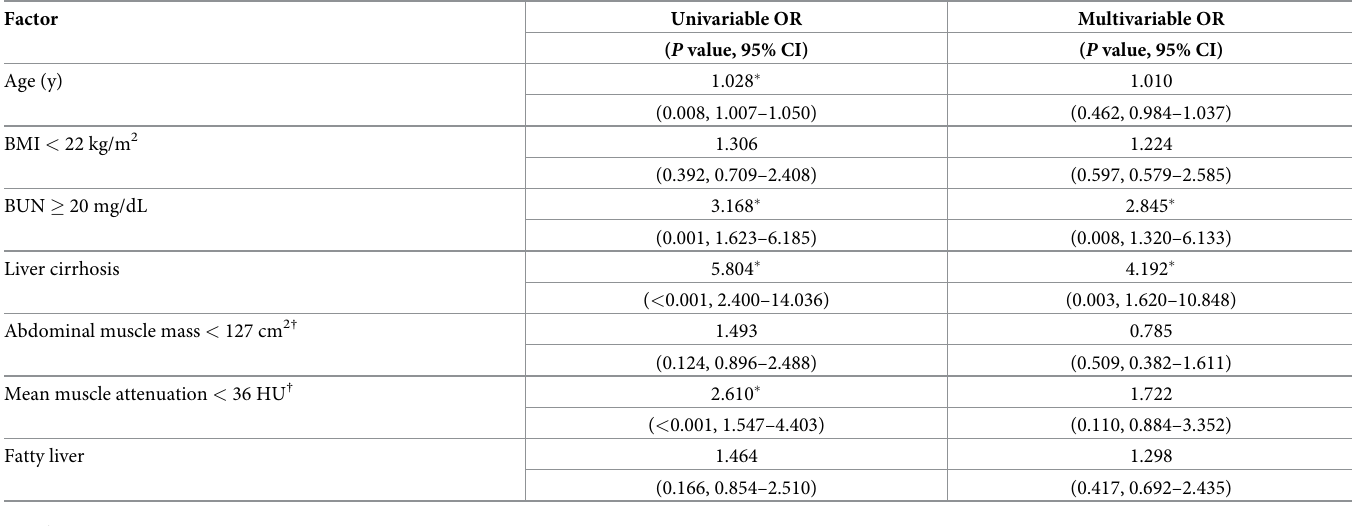
Table 3. Risk factors of moderately severe or severe alcoholic acute pancreatitis.